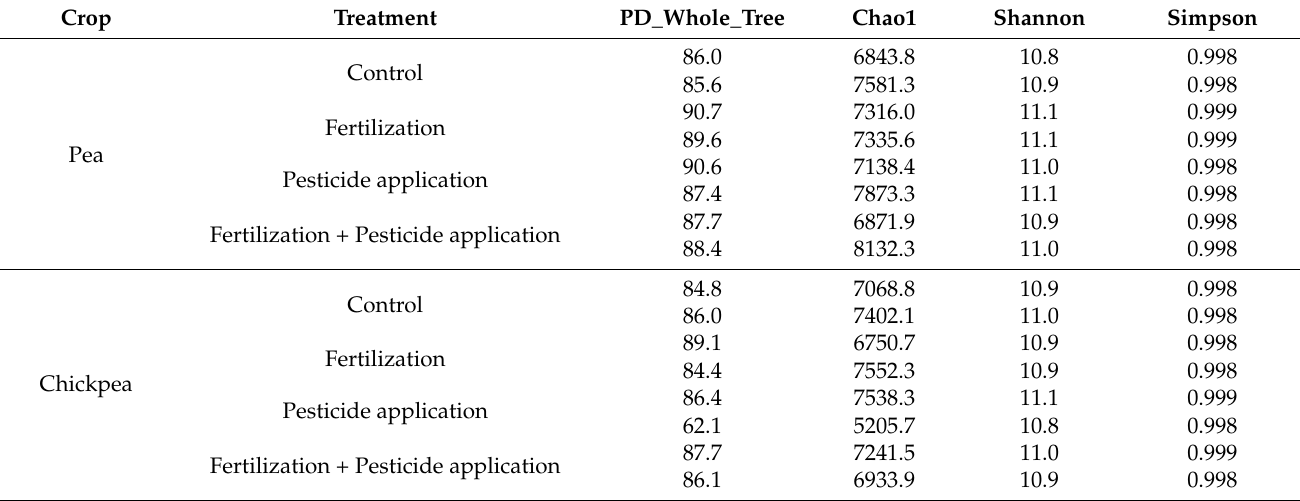
Table A1. Indices of the α -diversity of bacterial communities.